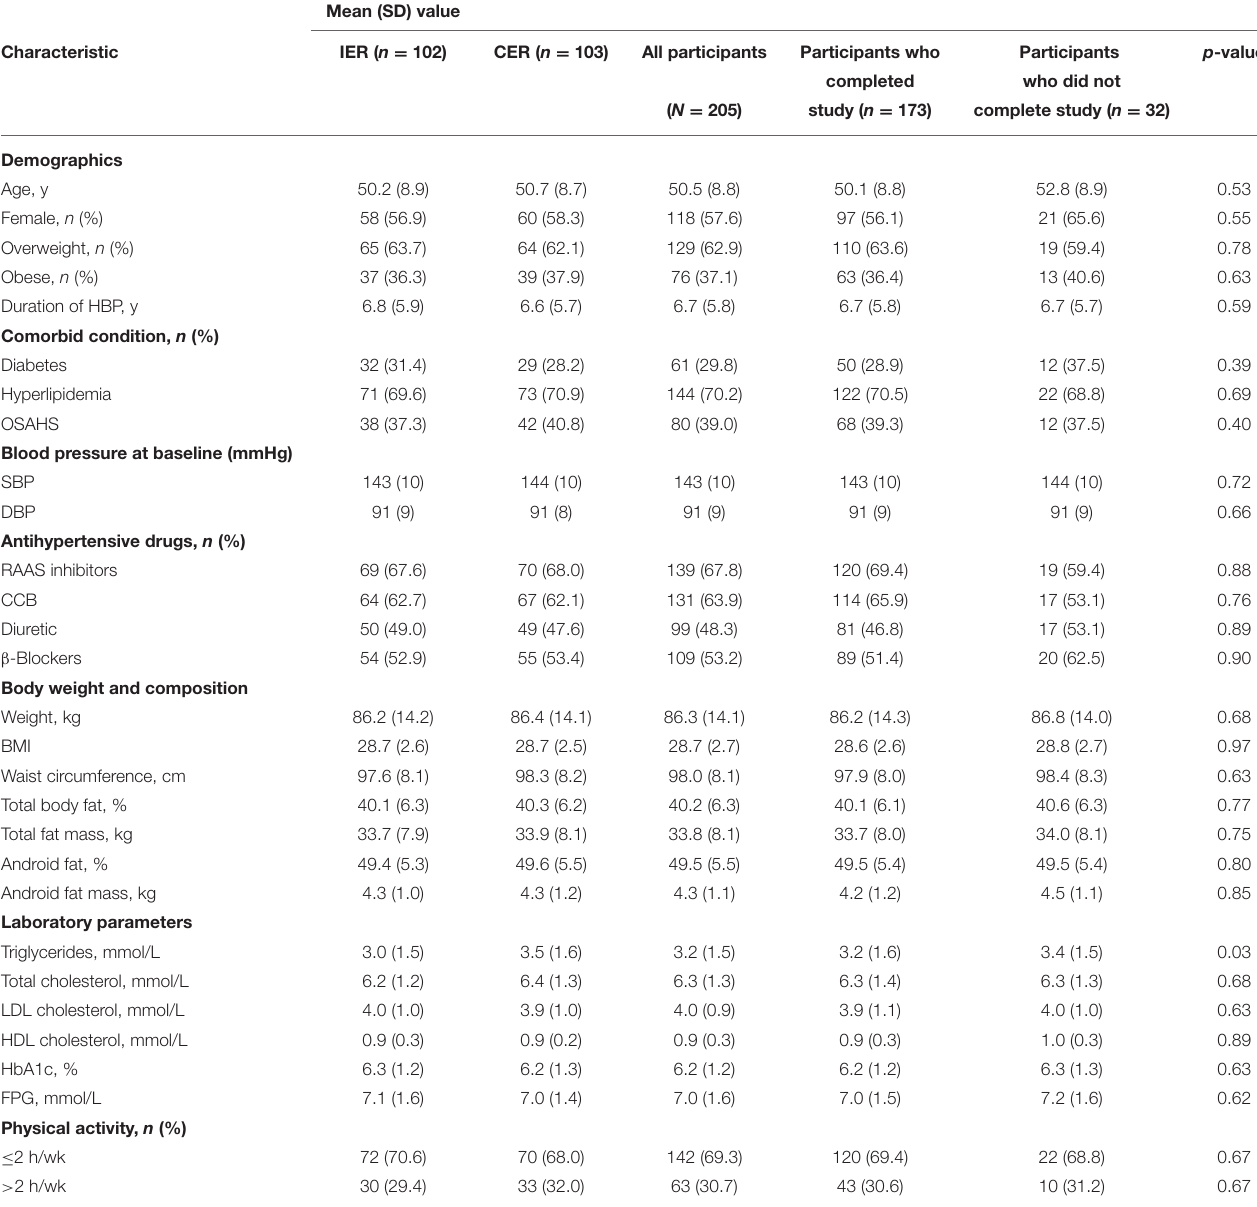
TABLE 1 | Demographic and clinical characteristics of the study